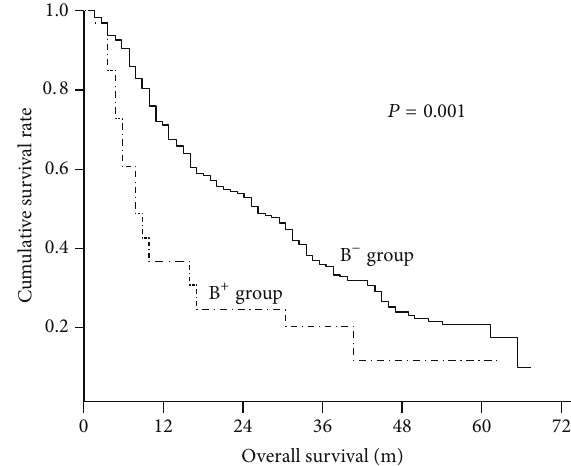
Figure 1: Kaplan-Meier curves of overall survival of hepatocellular carcinoma patients with bile duct invasion (B + group, 𝑛 = 35 ) and without bile duct invasion (B − group, 𝑛 = 378 ).